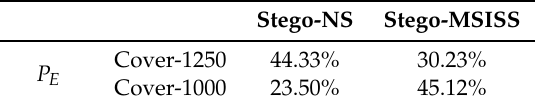
Table 3. The undetectability results between cover images with NS and MSISS-NS.